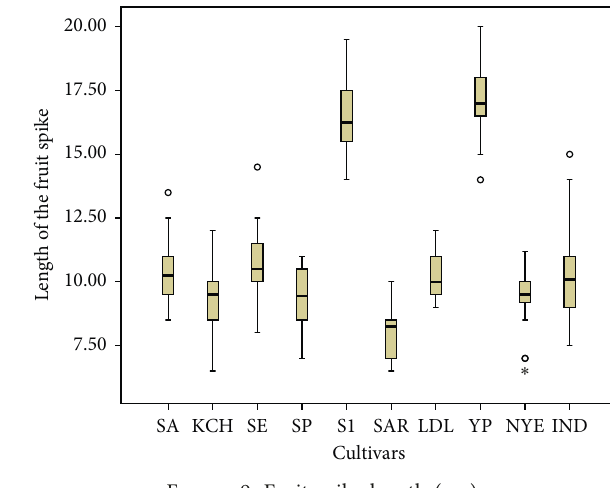
Figure 9: Fruit spike length (cm).